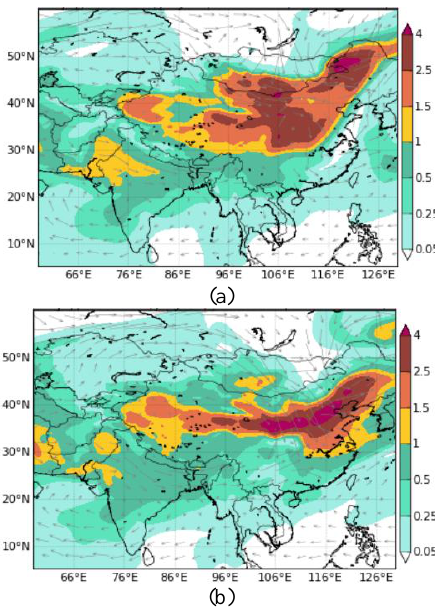
Figure 3. The dust load (g/m 2 ) and 3000m wind from the NMMB/BSC-Dust model: (a) 4 May 2017; (b) 5 May 2017 Figure 4 shows the VIIRS-Suomi NPP Level-2 aerosol optical depth (AOD) and angstrom exponent (AE) on 4 May. AOD in land and desert areas is inverted by Dark-Target algorithm and Deep Blue algorithm, but there is no inversion result when there are many clouds. It can be seen from the figure that in the desert area, the AOD value is larger and the AE value is smaller, indicating that the sand source is dominated by the coarse mode. At this time, the dust that invaded the Beijing-Tianjin-Hebei region was also dominated by the coarse model.